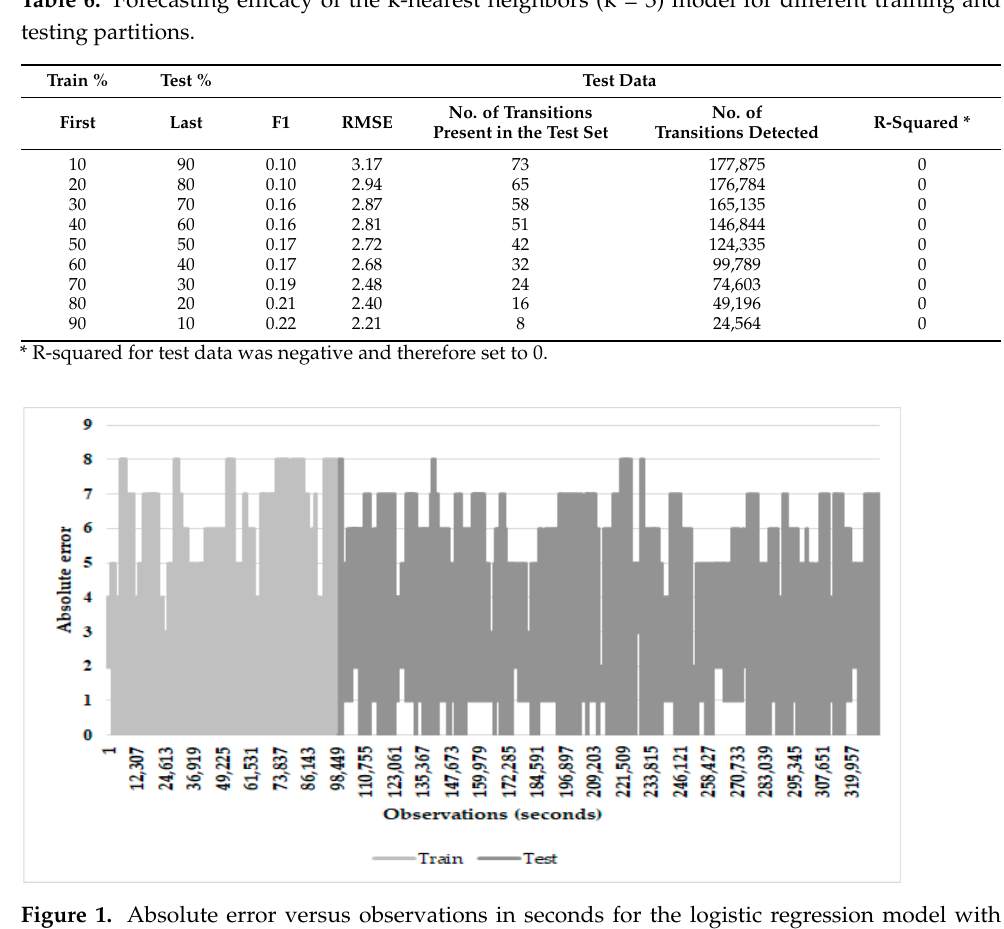
Table 4. Forecasting efficacy of the logistic regression model for different training and testing partitions.